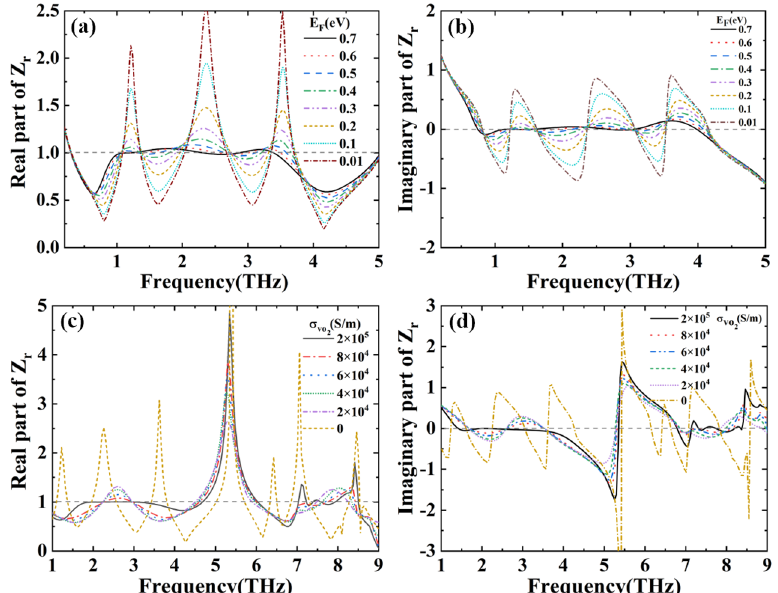
Z for different E ; ( c ) Real and r F Z for different VO 2 conductivities. r